Question: State the chart type depicted above.
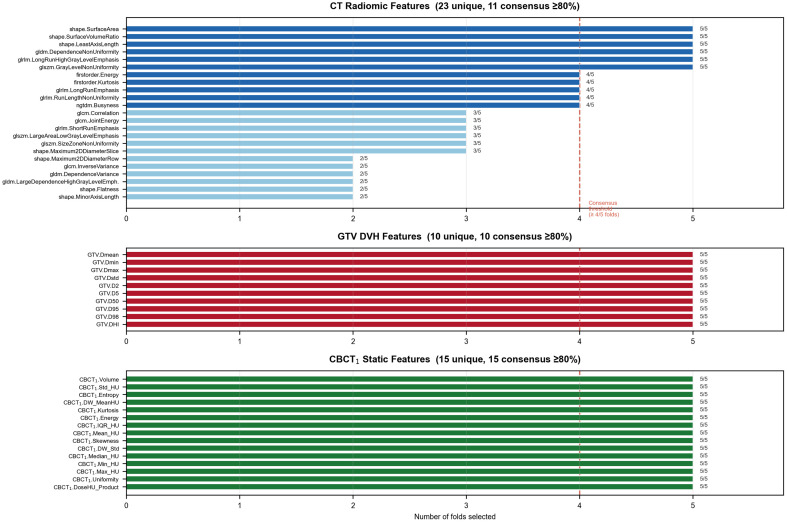
Answer: bar